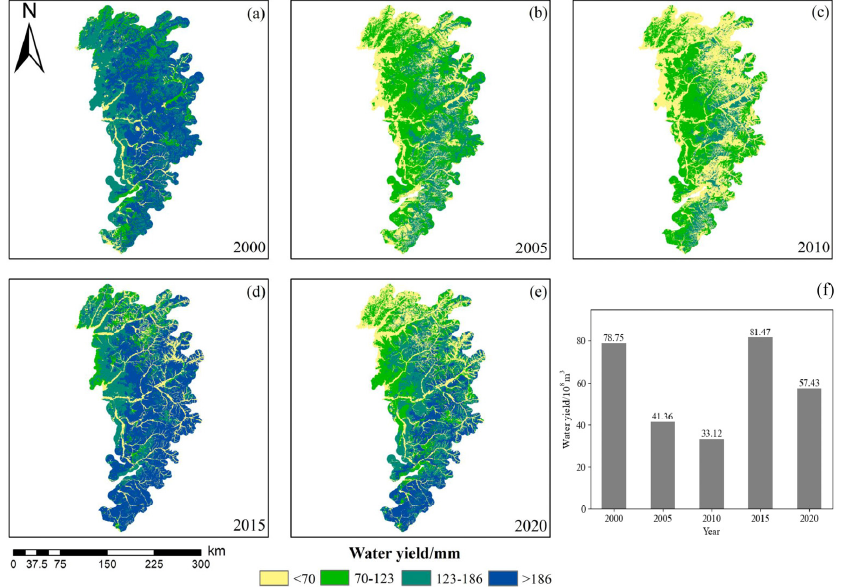
Figure 2. Temporal and spatial distribution of water yield in Hulunbuir forest–steppe ecotone from 2000 to 2020. ( a – e ) represent the spatial distribution of water yield in the Hulunbuir forest–steppe